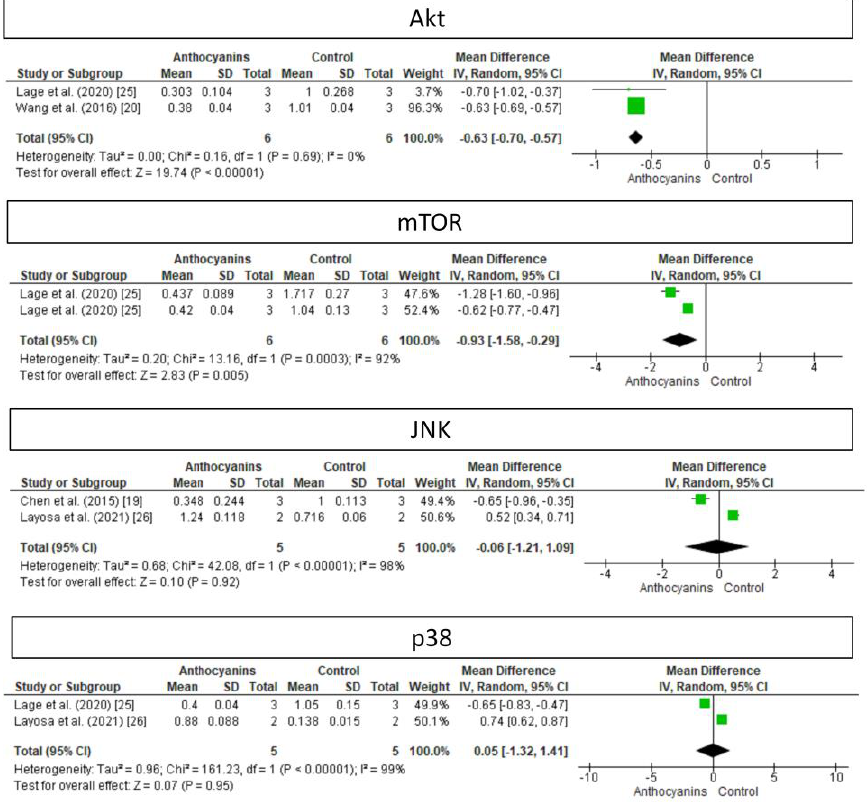
Figure 5. Forest plot of the meta-analysis comparing the anthocyanins TNBC cell line versus the untreated controls in migration, and in the modulation of Protein kinase B (Akt), Mammalian Target of Rapamycin (mTOR), c-Jun N-terminal kinase (JNK), and p38. IV: inverse variance based on the mean difference; CI: confidence interval. The green box in the middle of each horizontal line represents the point estimate of the effect for each study (the larger the size of the green box, the greater the weight of the study). The black diamond represents the effect estimate of all meta-analysis studies. The position of the diamond indicates which group was significant in modulating the parameter (e.g., if the diamond is on the left side, it means that the anthocyanin group modulated the parameter. However, if the diamond touches the central vertical line, it means that there is no difference between control and anthocyanin groups) [19,20,25,26].